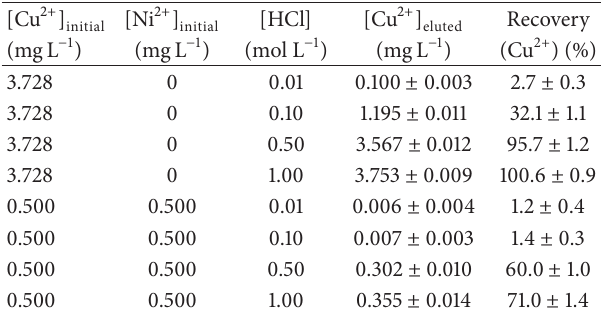
Table 4: Recovery of Cu 2+ after percolation of 30.0 mL of solution in the column filled with SGAPC.